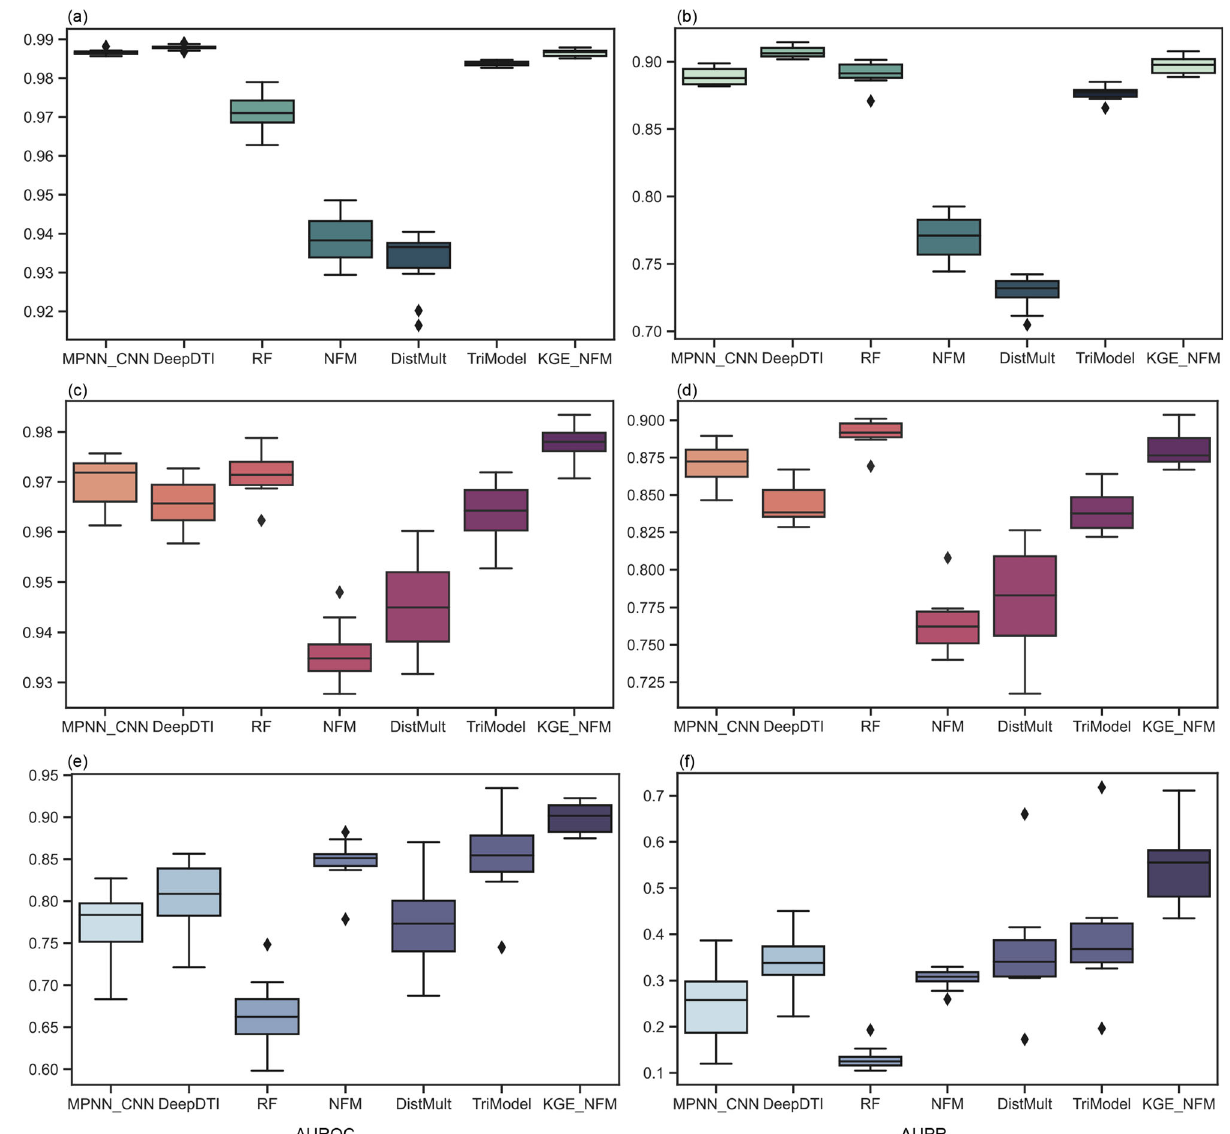
Fig. 3 Evaluation performance on the BioKG dataset in three sample scenarios. All the results were obtained by 10-fold cross-validations. The ratio between the positive and negative samples is about 1:10. N = 10 independent experiments. Box plots show the median as the center lines, upper and lower quartiles as box limits, whiskers as maximum and minimum values, and dots represent